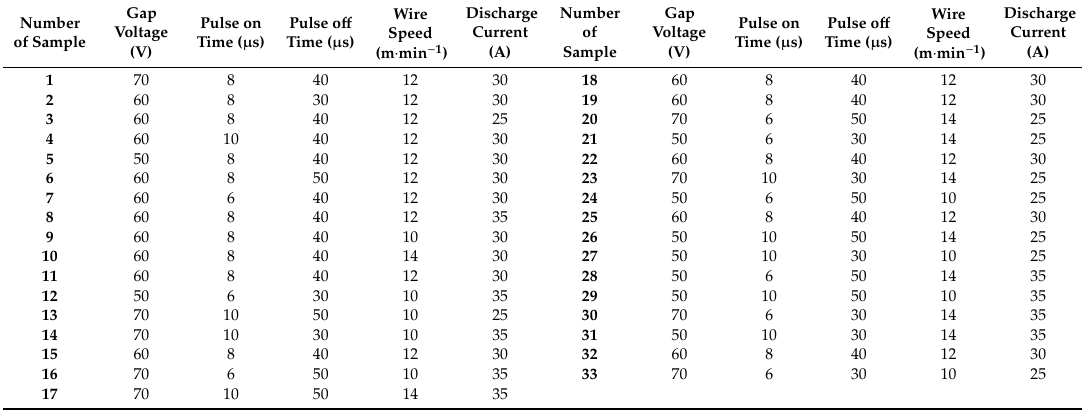
Table 1. Used in the